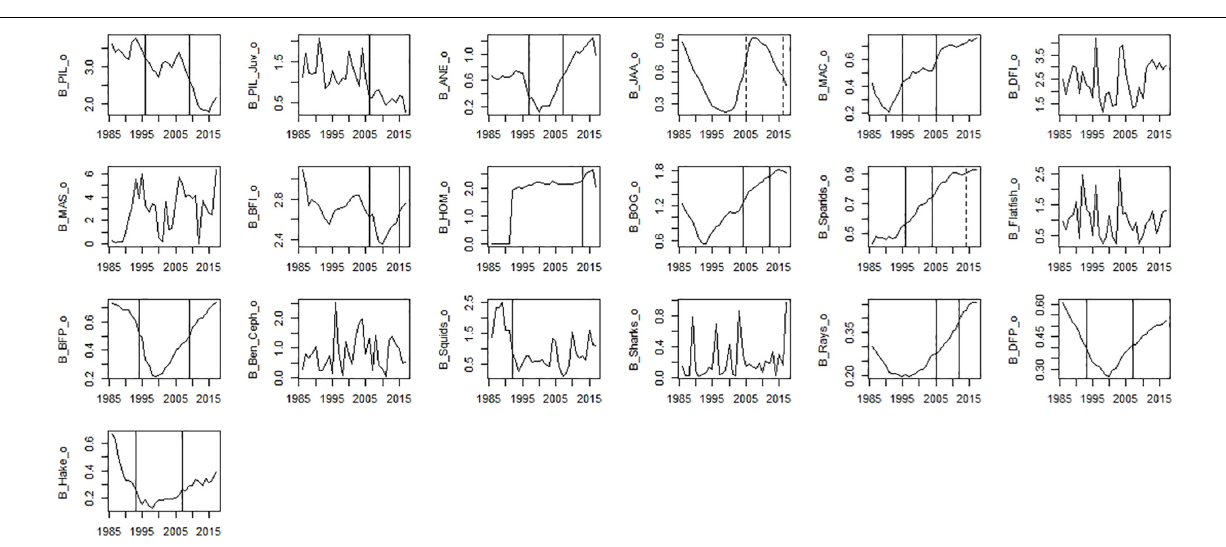
For STARS performed on PC trends of ecosystem indicators, significant shifts in the ecosystem were detected in 1992 for PC2_indices, 1999 for PC1_indices, and 2011 and 2012 for PC2_indices and PC1_indices, respectively ( Table 6 ). The CC showed discontinuity in the ecosystem indicators data in 1990, 1999, and 2012 ( Table 6